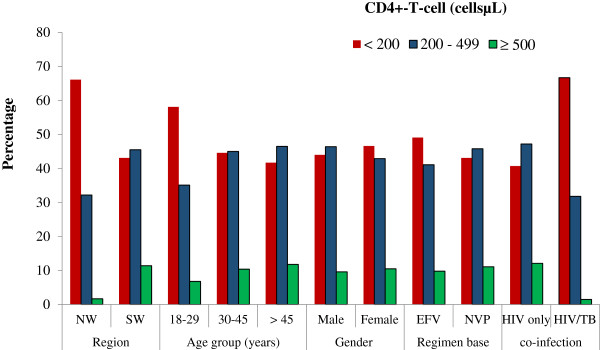
Prevalence of immunologic categories among study participants.